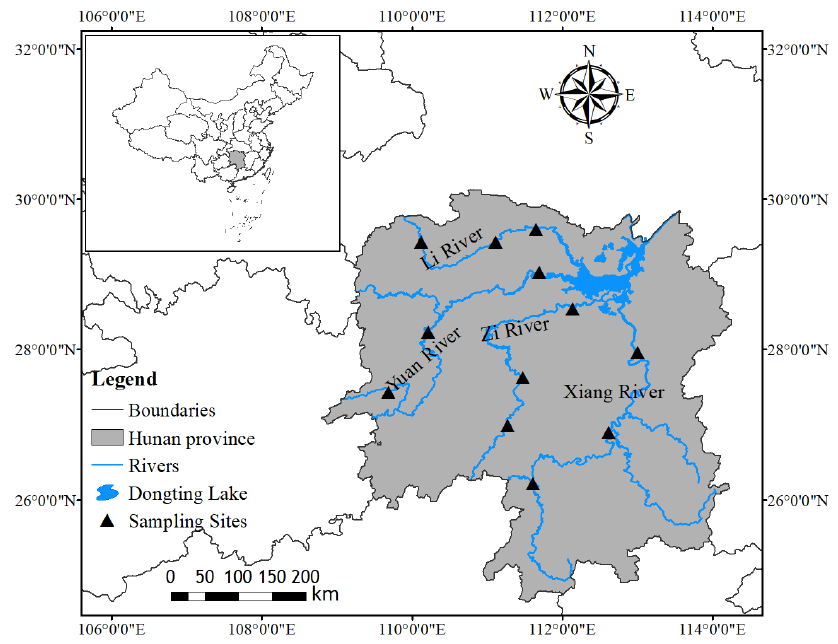
Figure 1. Study area and sampling locations in the four tributaries of Dongting Lake,